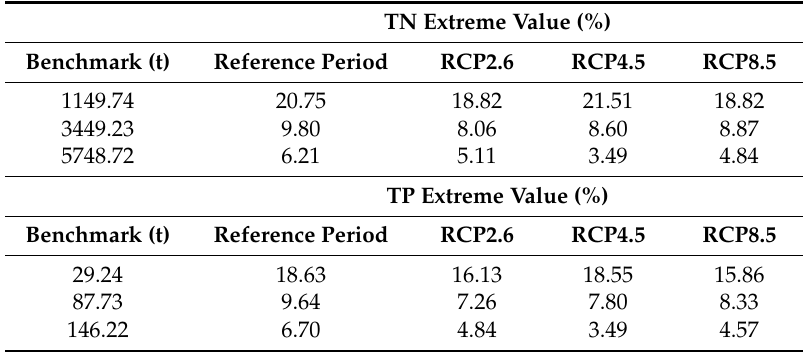
Table 9. The extreme values of TN and TP load under the Future Climate Change